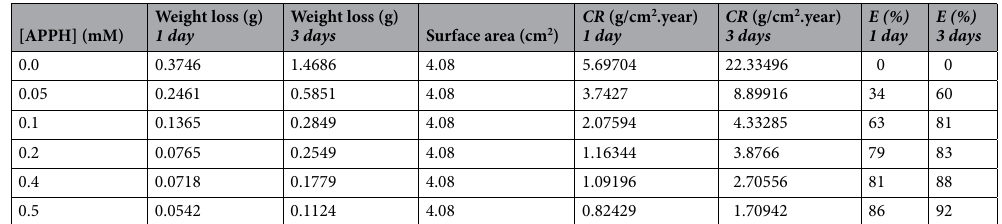
Table 1. Effect of APPH concentrations on the corrosion rate of carbon steel in 0.5 M H 2 SO 4 .